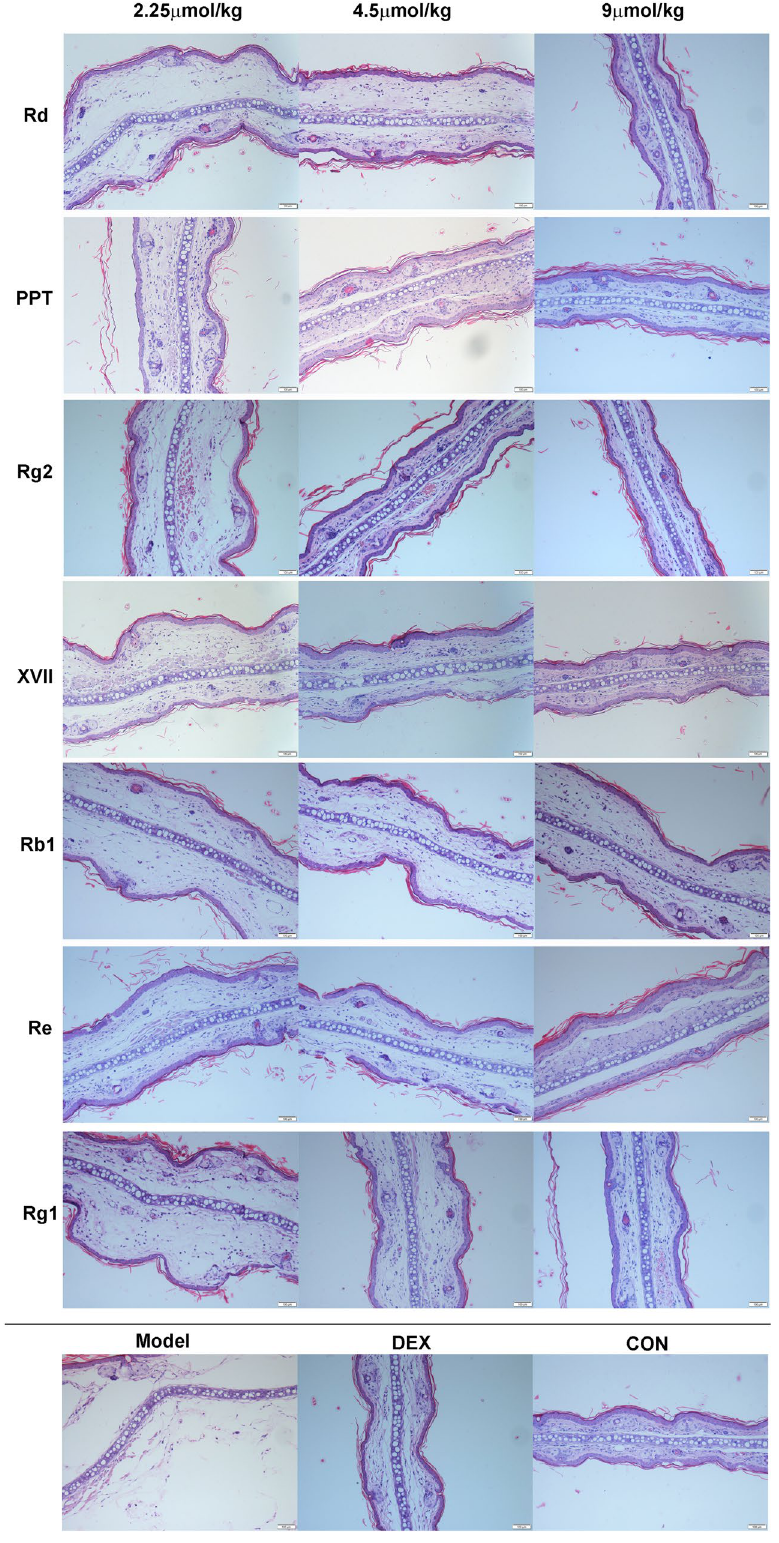
Figure 5. Histopathology analysis of the inhibitory effect of ginsenosides on xylene-induced inflammatory response in mouse ear swelling. Scale bars, 100 μ m. Magnification, 200 ×